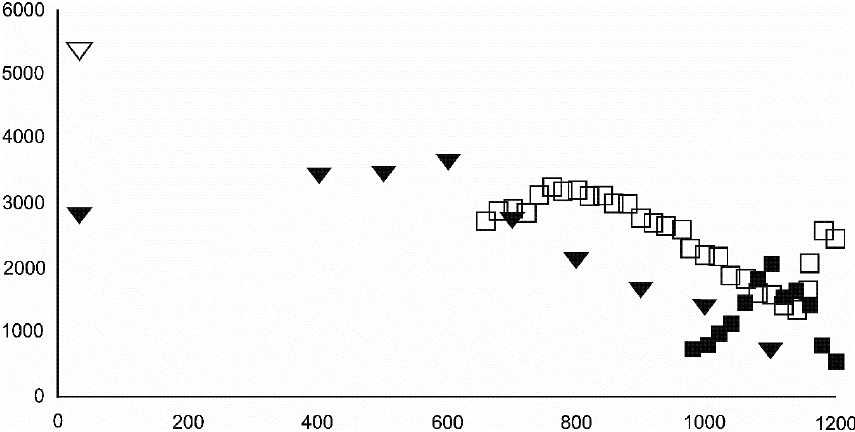
Figure 17. Relationship of temperature (bottom axis, in °C) to position of the major reflection (in Å) for olivine. Symbols as in Figure 1.